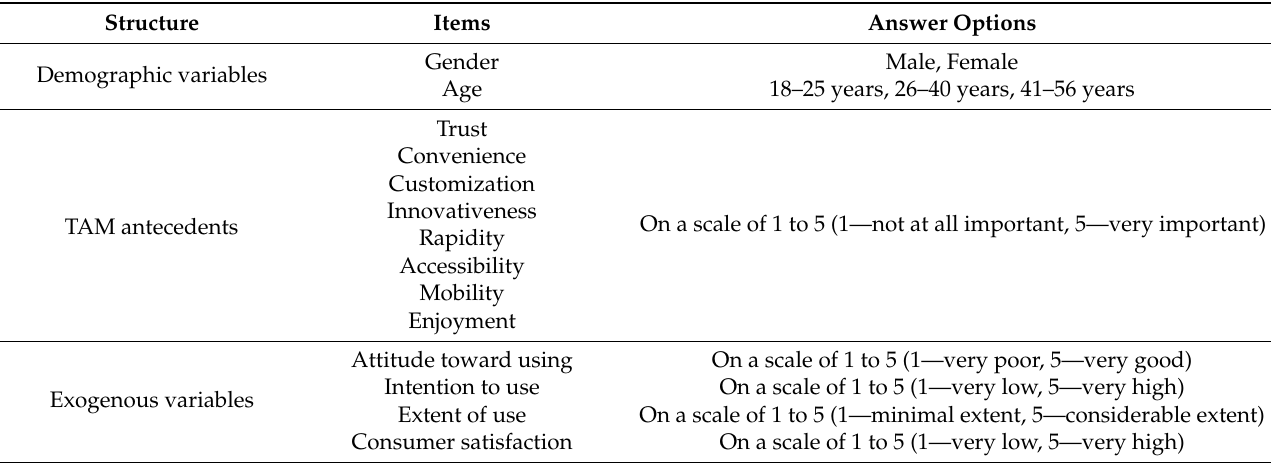
Table 2. Questionnaire design (constructs and